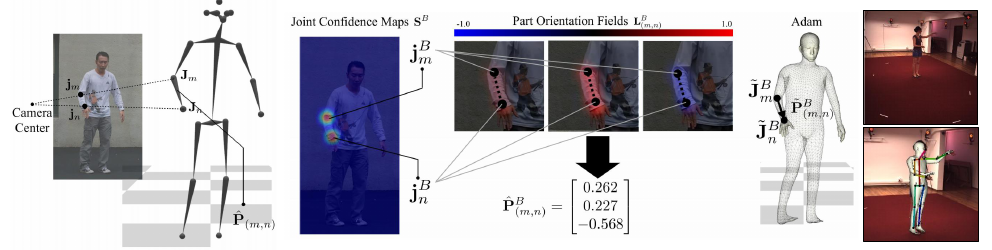
Figure 2. Example of monocular 3D joint detector (Adapted from ref